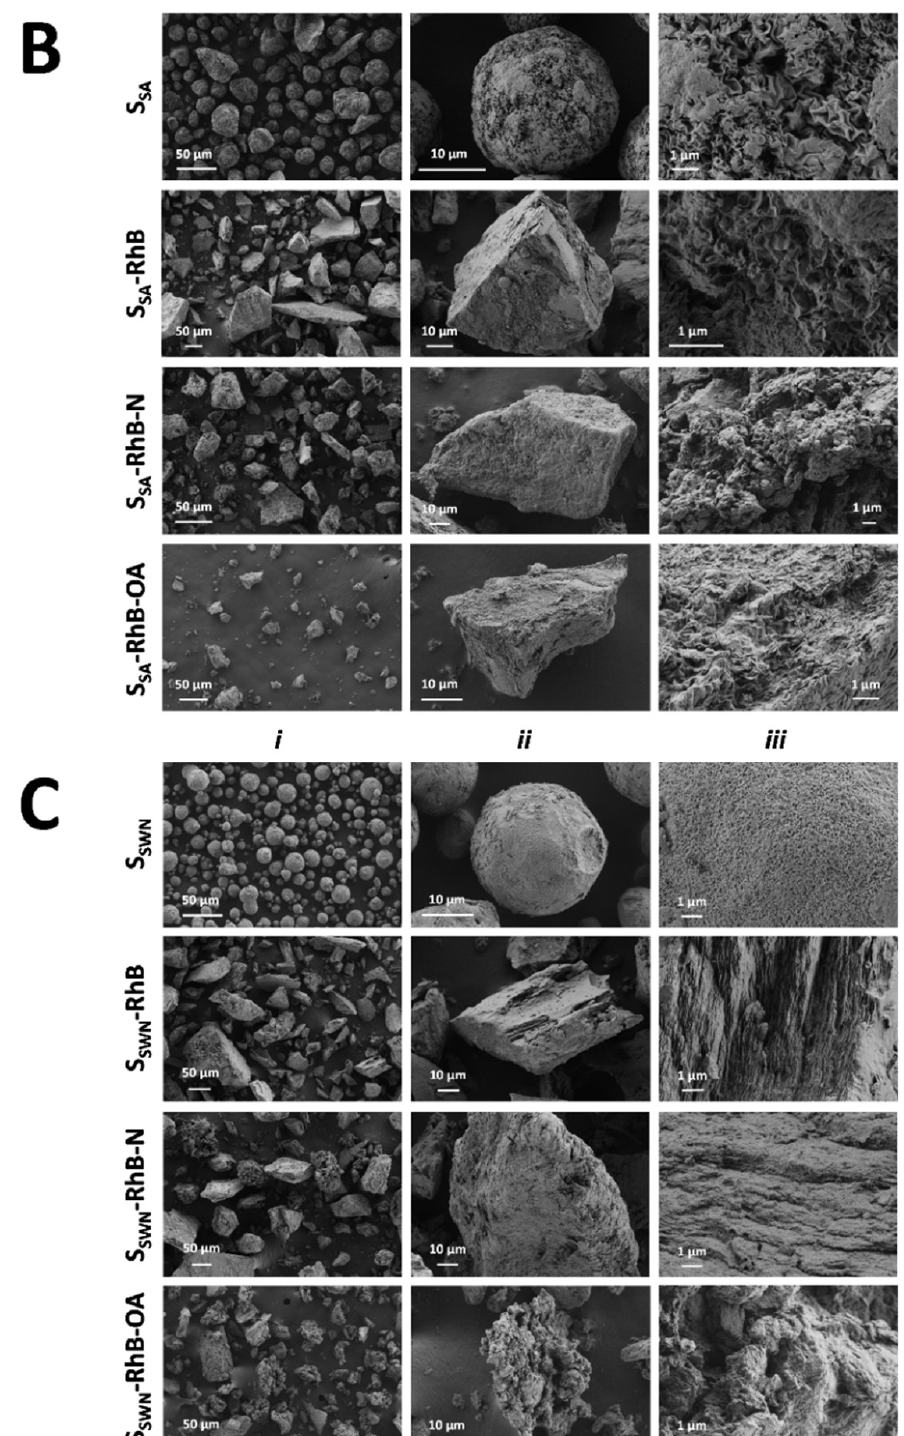
Figure 2. FESEM micrographs of the obtained solids in the different steps of synthesis of ( A ), K F -RhB-OA; ( B ), S SA -RhB-OA; and ( C ), S SWN -RhB-OA. General view of the particles (i), image of a representative particle (ii) and surface detail